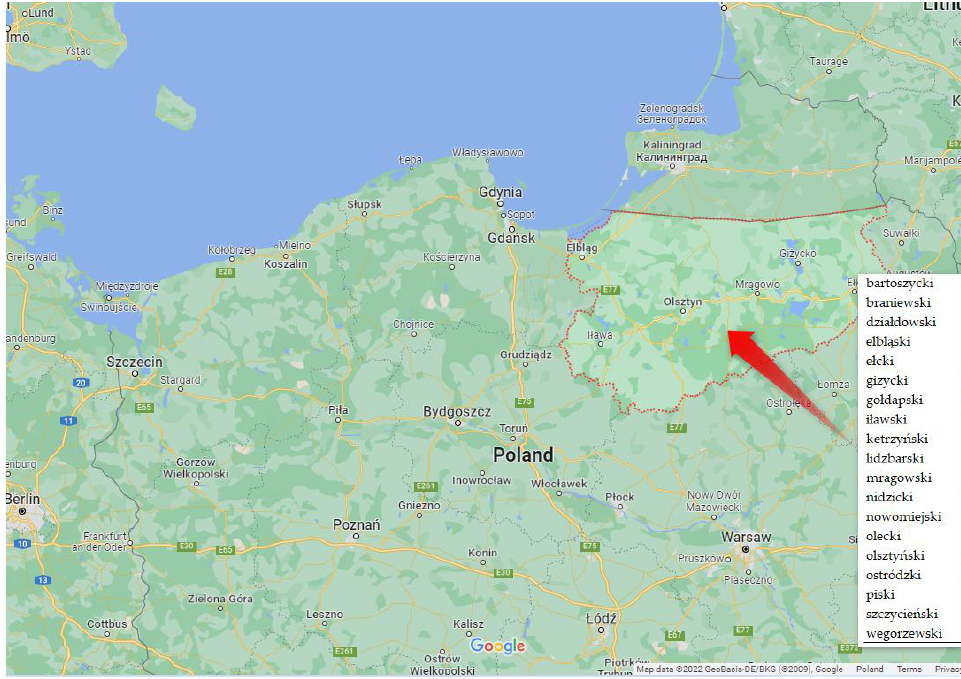
Figure 2. Location of the study area. Source: [86].